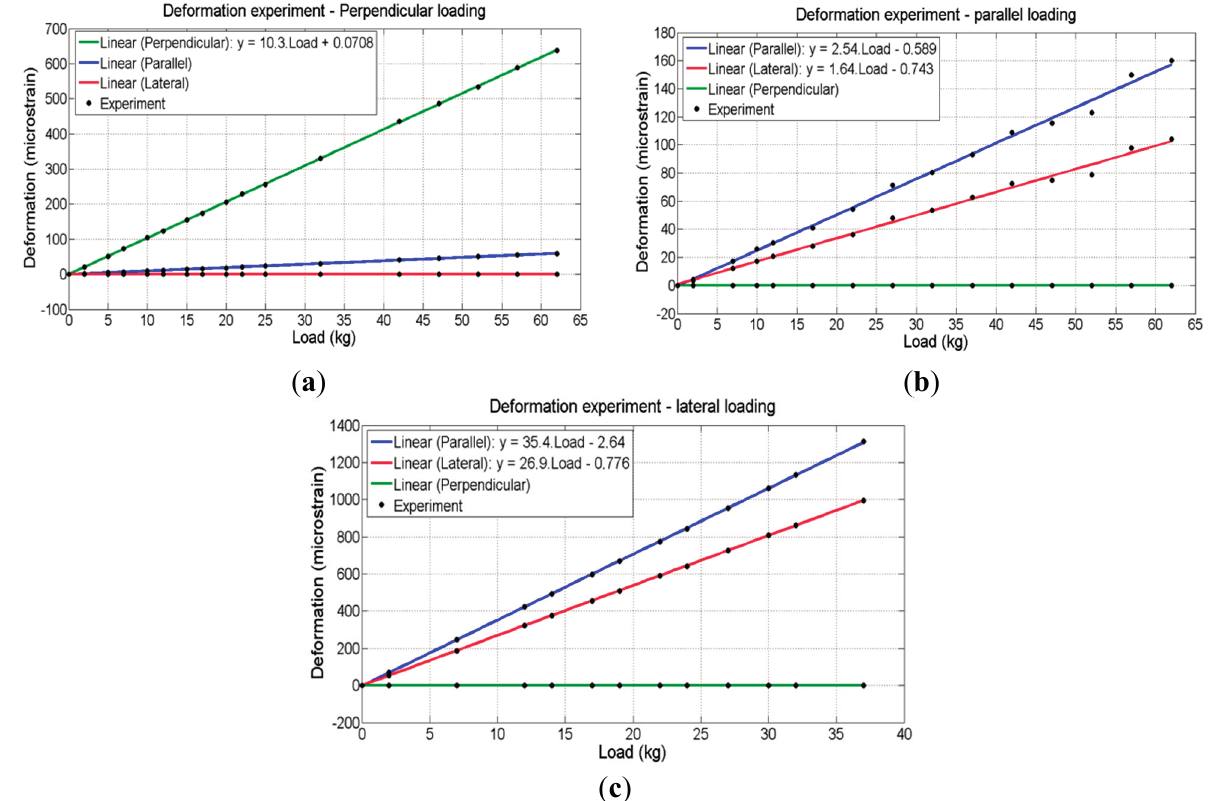
Figure 12. Deformation experiment results for the left load cell: ( a )